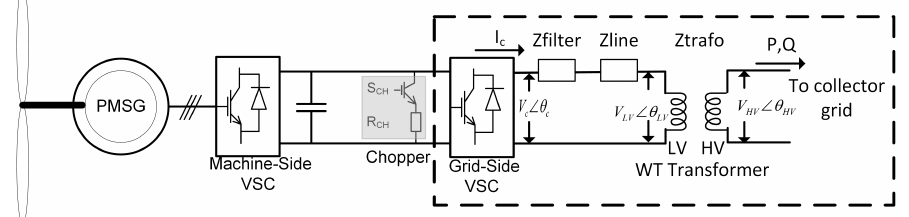
Figure 1. Schematic representation of Type 4 (full rated converter based) wind turbine (WT) connected